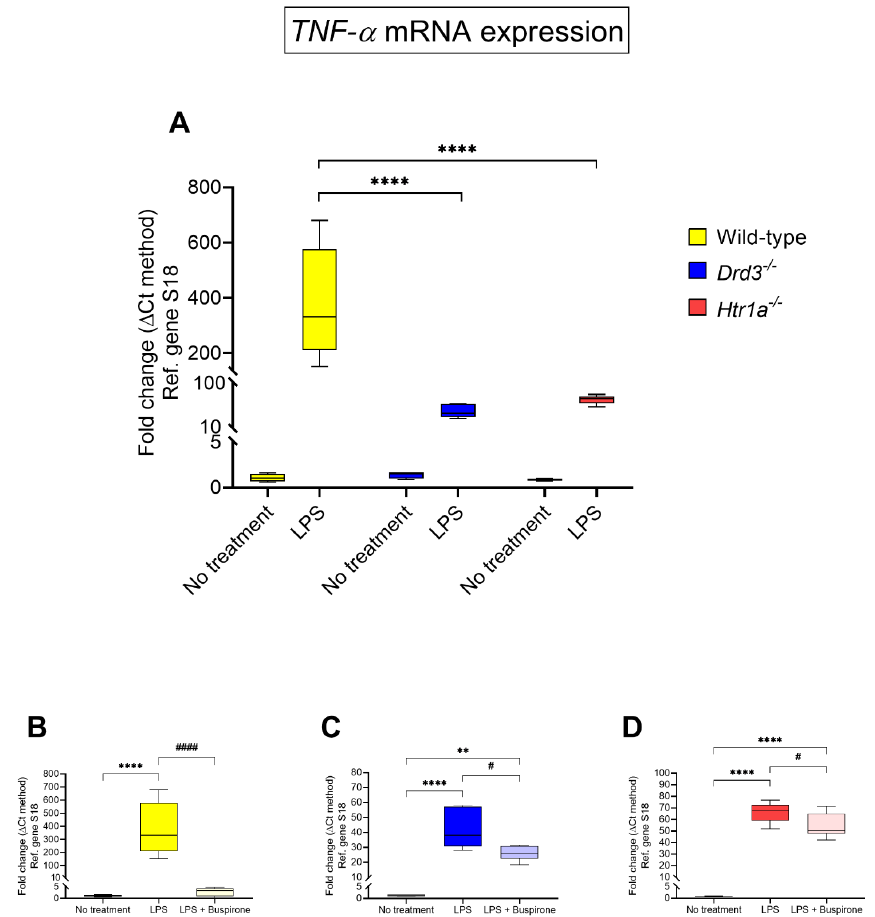
Figure 6. TNF- α mRNA expression following exposure to LPS and treatment with buspirone for 24 h. Gene expression was measured using real-time qPCR and quantified using the ∆∆ Ct method after normalization to the S18 housekeeping gene. ( A ) Box and whisker plots showing the differential expression of TNF- α transcripts in untreated or LPS-treated wild type, Drd3 − / − and Htr1a − / − cells or after co-treatment of ( B ) wild type, ( C ) Drd3 − / − and ( D ) Htr1a − / − cells with LPS in combination with buspirone. Results are presented as mean fold changes with respect to no treatment (control) ± SEM. Baseline levels of no treatment groups were set to 1. ** p < 0.01 or **** p < 0.0001 vs. no treatment or # p < 0.05 and #### p < 0.0001 vs. LPS, as determined by one-way or two-way ANOVA followed by Tukey or Dunnett’s post-hoc